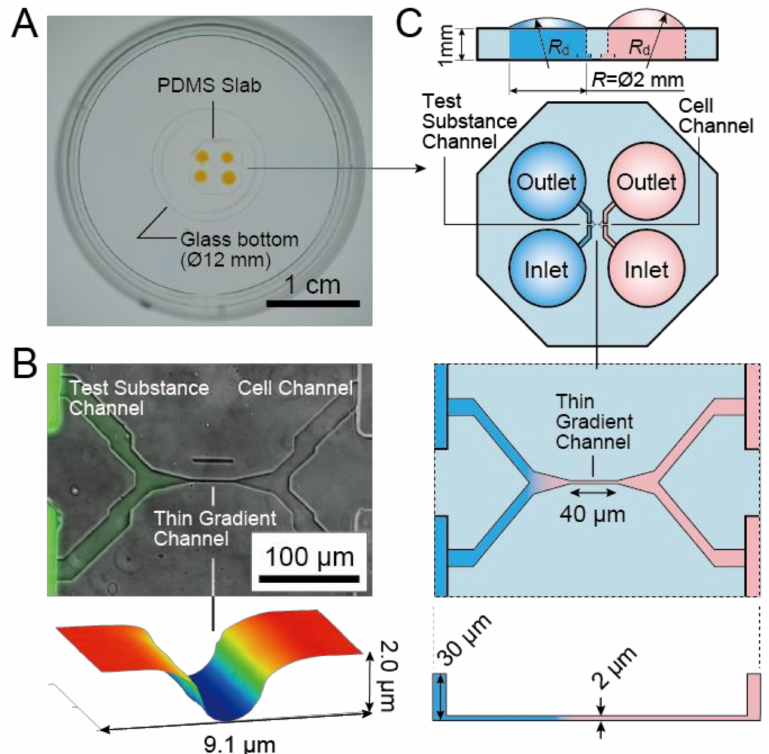
Figure 1. ( A ) A microfluidic gradient generator: a poly(dimethylsiloxane) (PDMS) slab with microchannel features and four holes bonded on a glass-bottom dish. ( B ) Micrograph of the microfluidic channels at the center of the PDMS slab. Fluorescence dye introduced to the channels is overlaid on the phase contrast image. A gradient of fluorescence is generated from the Test Substance Channel to the Cell Channel through the Thin Gradient Channel. A height image of the thin channel indicates that the top height and the width of the thin channel are approximately 2.0 µ m and 3 µ m. ( C ) Illustration of the channel configuration of the microfluidic chip: a symmetrical H-shaped channel with a thin channel at the center. No cell body but axons can pass through the thin channel. Due to the high flow resistance of the thin channel and slow diffusion rate of the test factor, a concentration gradient along the thin channel is